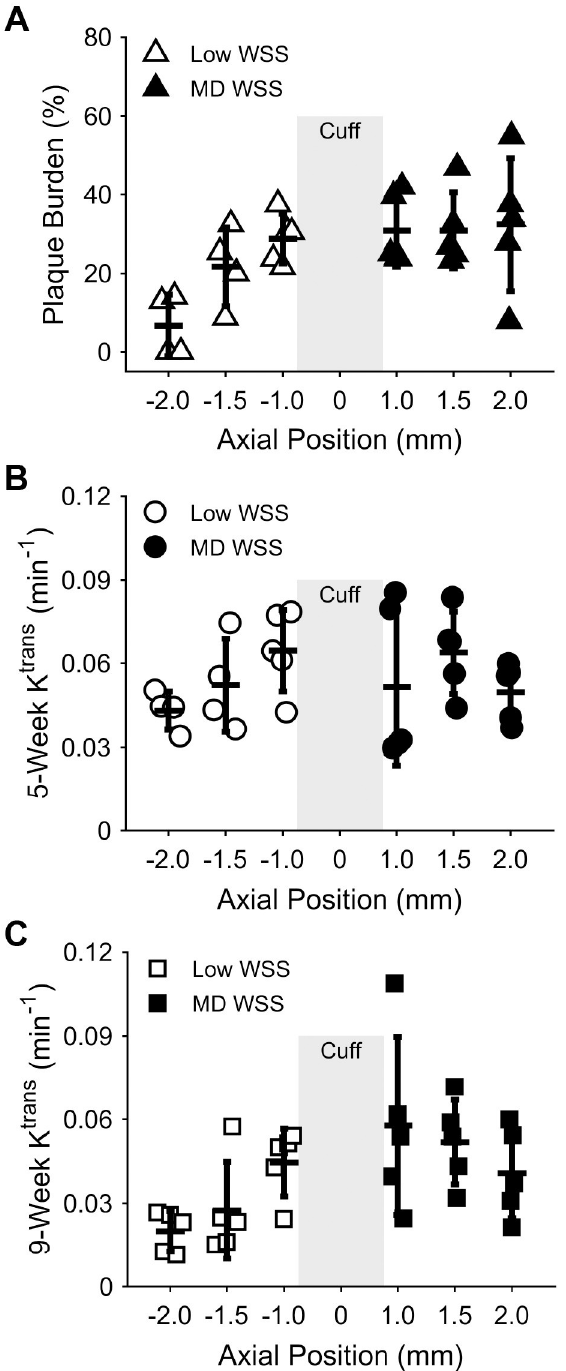
Fig 3. Plaque burden and NP accumulation over the length of the instrumented artery. (A) Plaque burden in mice injected with NPs at 9 weeks after cuff placement, (B) NP accumulation assessed via K trans at 5 weeks after cuff placement, and (C) K trans at 9 weeks after cuff placement as a function of position (in mm) from the center of the cuff (no plaque developed in the cuff region and there are no K trans values due to the cuff creating an unreliable signal; thus, no data are presented in this region). Data points represent the mean plaque burden and K trans values for each mouse injected with NPs ( n = 5) at each MRI slice location. Bars are mean ± SD. These data were not evaluated for statistical differences between vessel